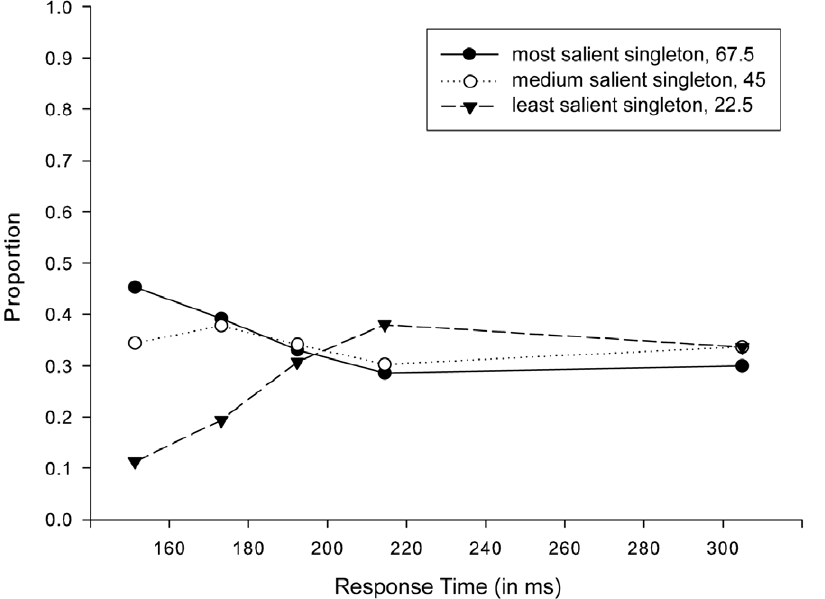
Figure 2. Salience-driven selection in initial saccades in Experiment 1. Proportions of initial saccades directed towards each of the three singletons (22.5 u , 45 u and 67.5 u ), separately for each bin of the response time distribution and irrespective of target identity.